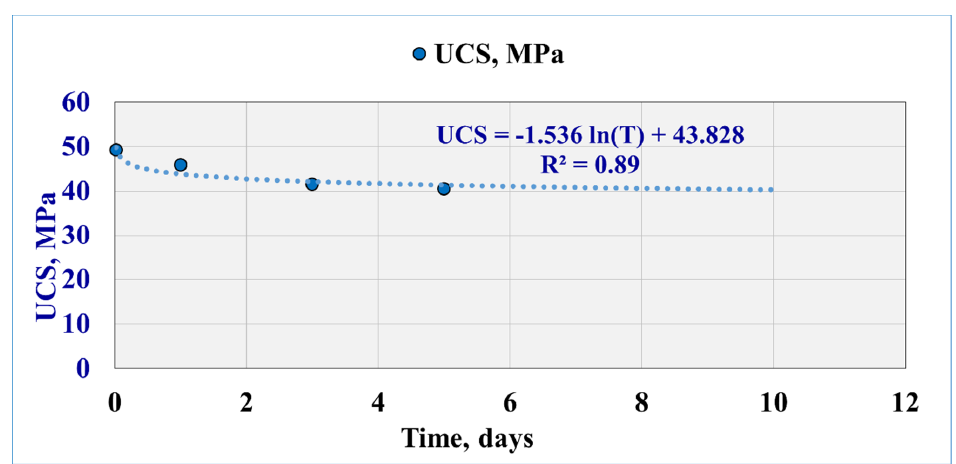
Figure 6. Strength alteration with an extended time of interaction with barite-weighted WBM.